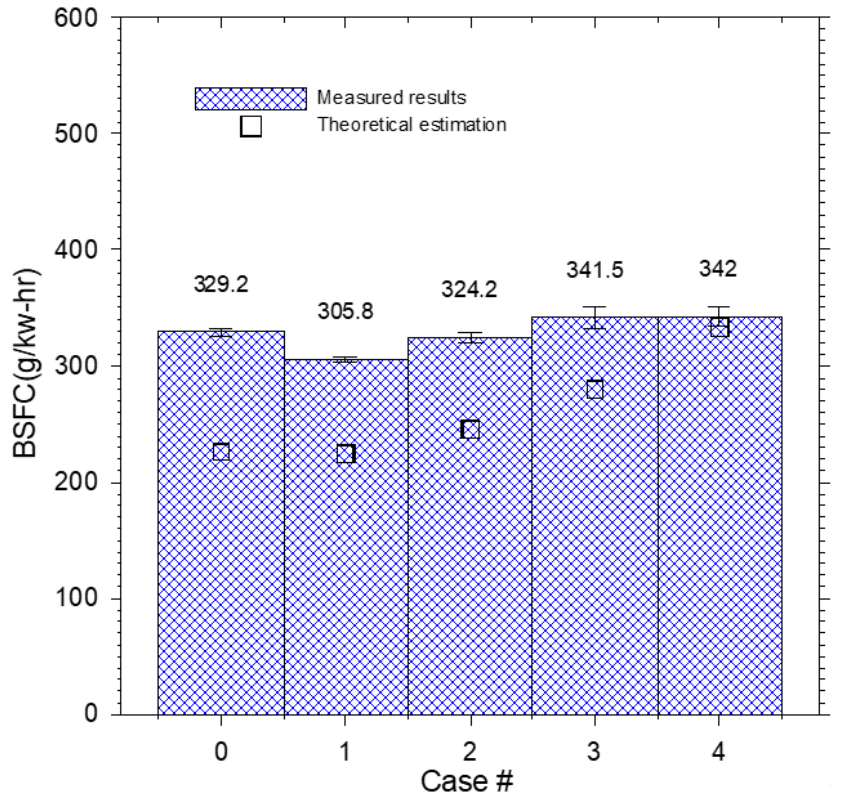
Figure 4. Comparison of measured and theoretically estimated brake specific fuel consumption (BSFC) for different valve settings.